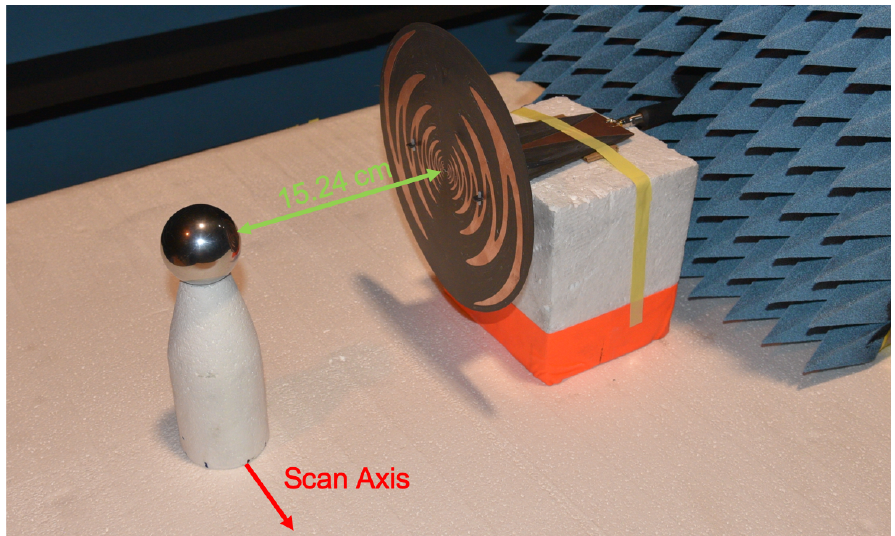
Figure 17. Setup of the validation measurement showing the fabricated 16-cell sinuous antenna and the 5.08 cm spherical target at the boresight scan